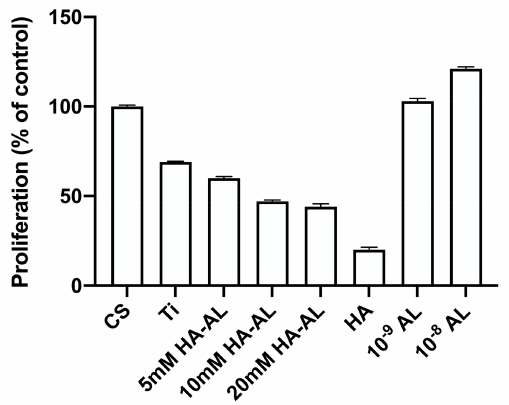
Figure 8. Evaluation of bone progenitor proliferation on implant grade titanium coated with MAPLE deposited HA-AL films.